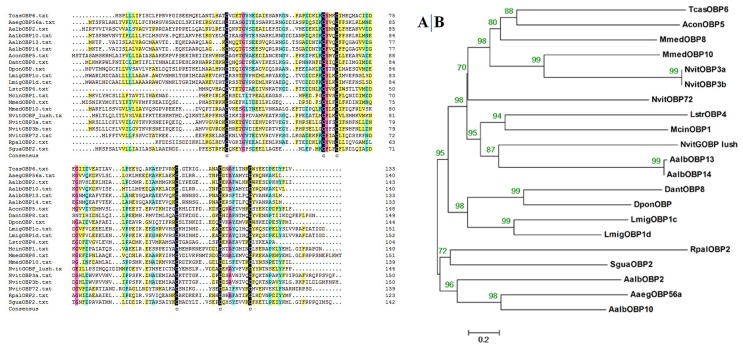
Alignments and Phylogenetic analysis of McinOBP1.(A) Alignment of McinOBP1(KF900276) from hymenopteran insects as well as other insects. Microplitis mediator (MmedOBP8, AEF14409)\ Rhynchophorus palmarum (RpalOBP2, AAD31883)\ Tribolium castaneum (TcasOBP5, EFA05677)\ Aedes aegypti (AaegOBP56a, XP_001658489)\ Nasonia vitripennis (NvitGOBP lush, XP_001603472)\ Aedes albopictus (AalbOBP10, AGI04311)\ Nasonia vitripennis (NvitOBP3a, CCD17772)\ Nasonia vitripennis (NvitOBP3b, CCD17860)\ Sclerodermus guani (SguaOBP2, ABE68831)\ Microplitis mediator (MmedOBP10, AEO27860)\ Dendroctonus ponderosae (DponOBP, ENN77432)\ Aedes albopictus (AalbOBP14, GI04314)\ Aedes albopictus (AalbOBP2, AFC60563)\ Aedes albopictus (AalbOBP13, AGI04313)\ Delia antiqua (DantOBP8, BAI82448)\ Argyresthia conjugella (AconOBP5, AFD34173)\ Locusta migratoria (LmigOBP1e, ACR39385)\ Laodelphax striatella (LstrOBP4, AEQ19910)\ Nasonia vitripennis (NvitOBP72, CCD17841). Six conserved cysteine residues are highlighted with black background (B) Phylogenetic tree of McinOBP1 amino acid sequences in others insects.